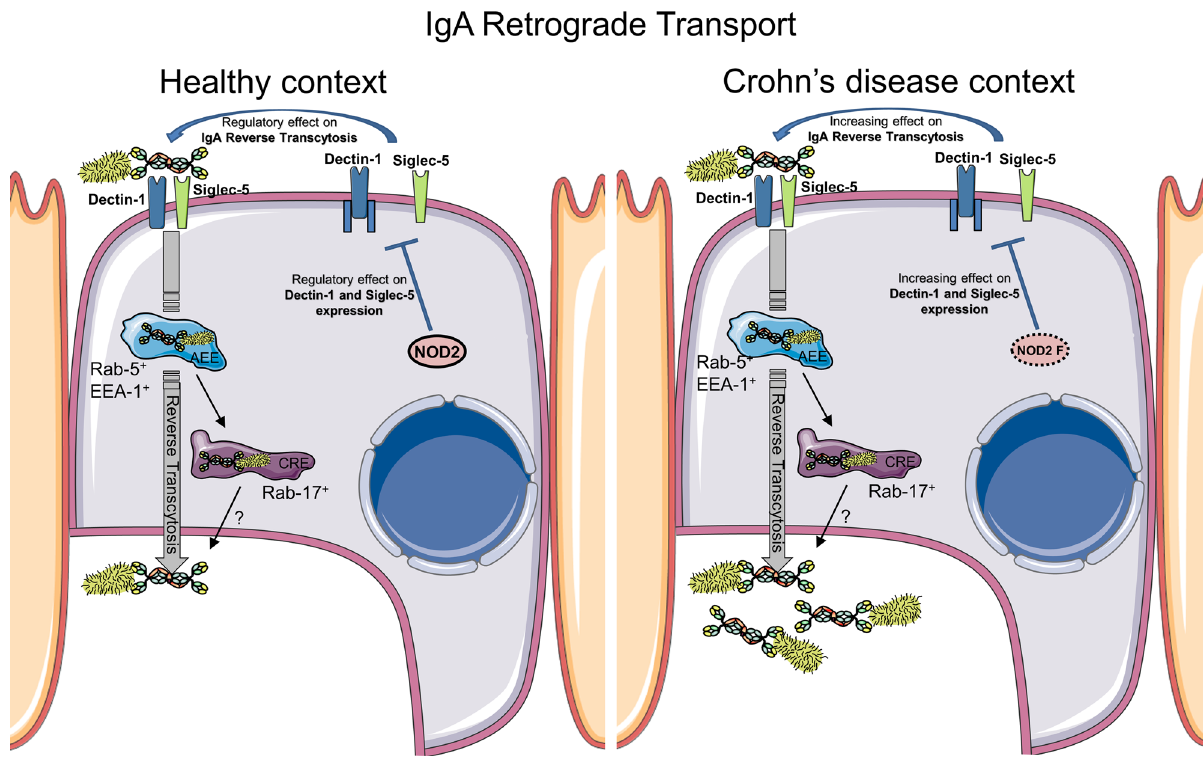
Fig. 6 The retrograde transport of IgA-pathogen complexes across M cells is increased in CD patients as compared to healthy individuals. This translocation of IgA is regulated by WT NOD2 upon decrease of Dectin-1 and Siglec-5 expression in M cells, ensuring proper homeostasis. This pathway is controlled by endosomal proteins such as EEA-1, Rab-5, and Rab-17. We would like to emphasize that this identi fi ed mechanism is likely one among others that is involved in the initiation and/or perpetuation of mucosal in fl ammation observed in CD